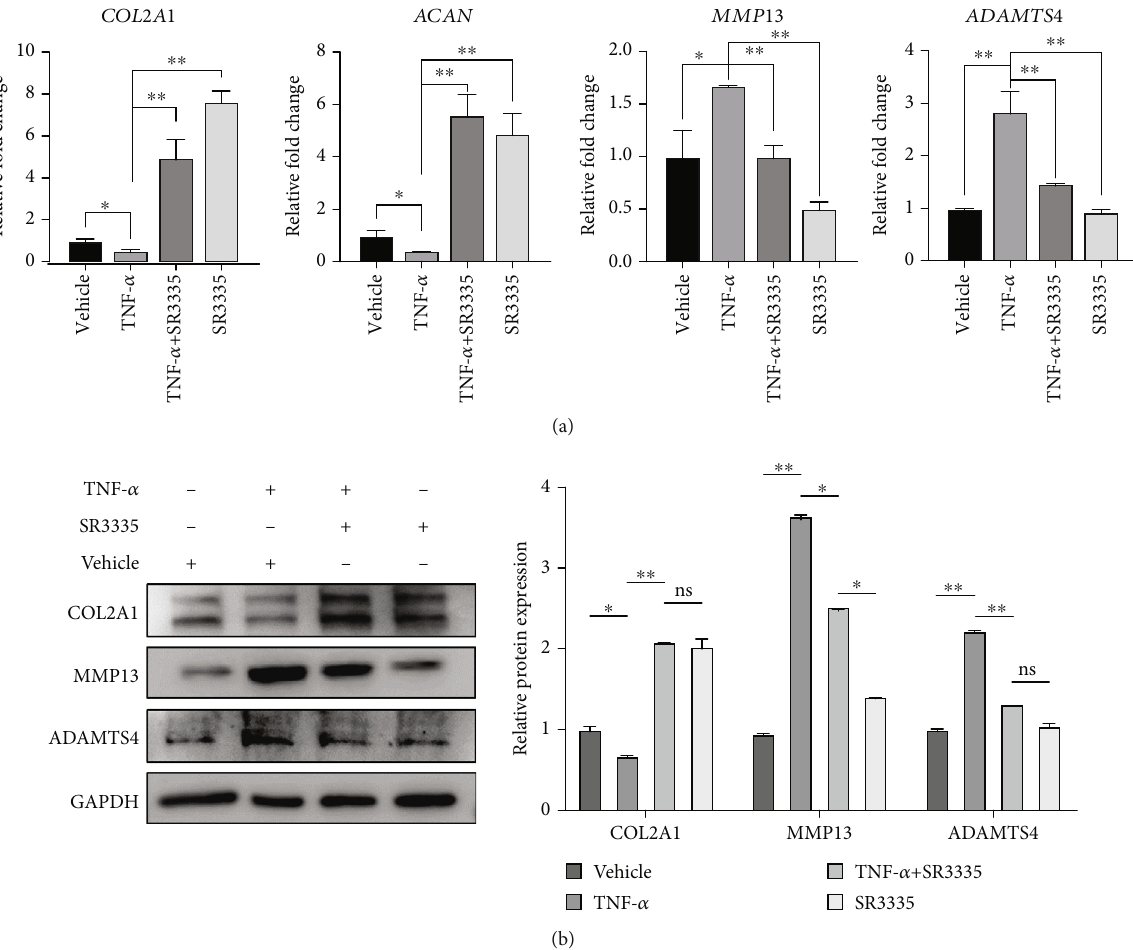
Figure 5: SR3335 treatment decreased the nucleus pulposus ECM catabolism upon TNF- α treatment. The NP cells were pretreated with 1 μ M of SR3335 2h before 10 ng/ml TNF- α treatment. (a) The mRNA level of COL2A1, ACAN, MMP13, and ADAMTS4 was assayed by real-time PCR. Data are expressed as mean ± SD . ∗ p < 0 : 05 , ∗∗ p < 0 : 01 , and ∗∗∗ p < 0 : 001 compared with the TNF- α treated group. (b) The protein level of COL2A1, MMP13, and ADAMTS4 was assayed by western blot and quanti fi